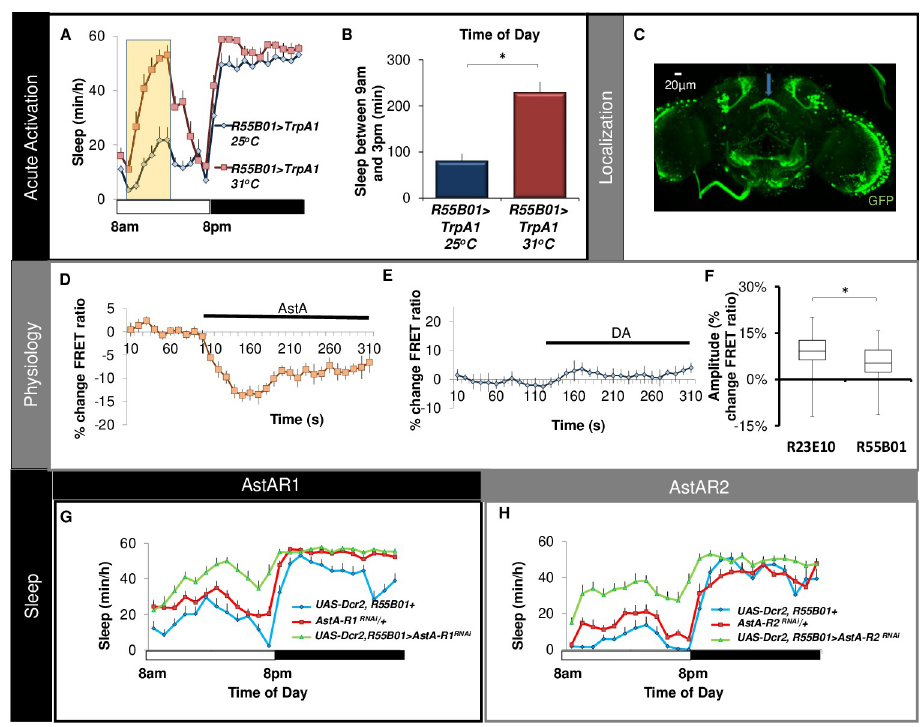
Fig 3. R55B01 neurons respond to AstA. ( A, B ) R55B01-GAL4 > UAS-dTrpA1 flies showed a significant increase in sleep at 31˚C (red) compared to siblings maintained at 25˚C (blue; n = 16/group). ( C ) Expression pattern of R55B01-GAL4 > UAS-GFP (blue arrow indicates the location of dFB). ( D ) Normalized FRET ratio in R55B01 > UAS-Epac1-camps in response to 1e − 6 M AstA ( n = 23 cells). ( E ) Normalized FRET ratio in R55B01 > UAS-Epac1-camps to 3e − 5 M DA ( n = 10). ( F ) Box plot comparing the response properties of R23E10 > UAS-Epac1-camps and R55B01 > UAS-Epac1-camps neurons to 3e − 5 M DA. The bottom and top of each box represents the first and third quartile, and the horizontal line dividing the box represents the median. The whiskers represent the minimum and maximum individual cell responses; n = 68 cells for R23E10 and n = 115 cells for R55B01 . ( G, H ) Knocking down AstA-R1 or AstA-R2 in R55B01 neurons increases sleep. Sleep in minutes per hour